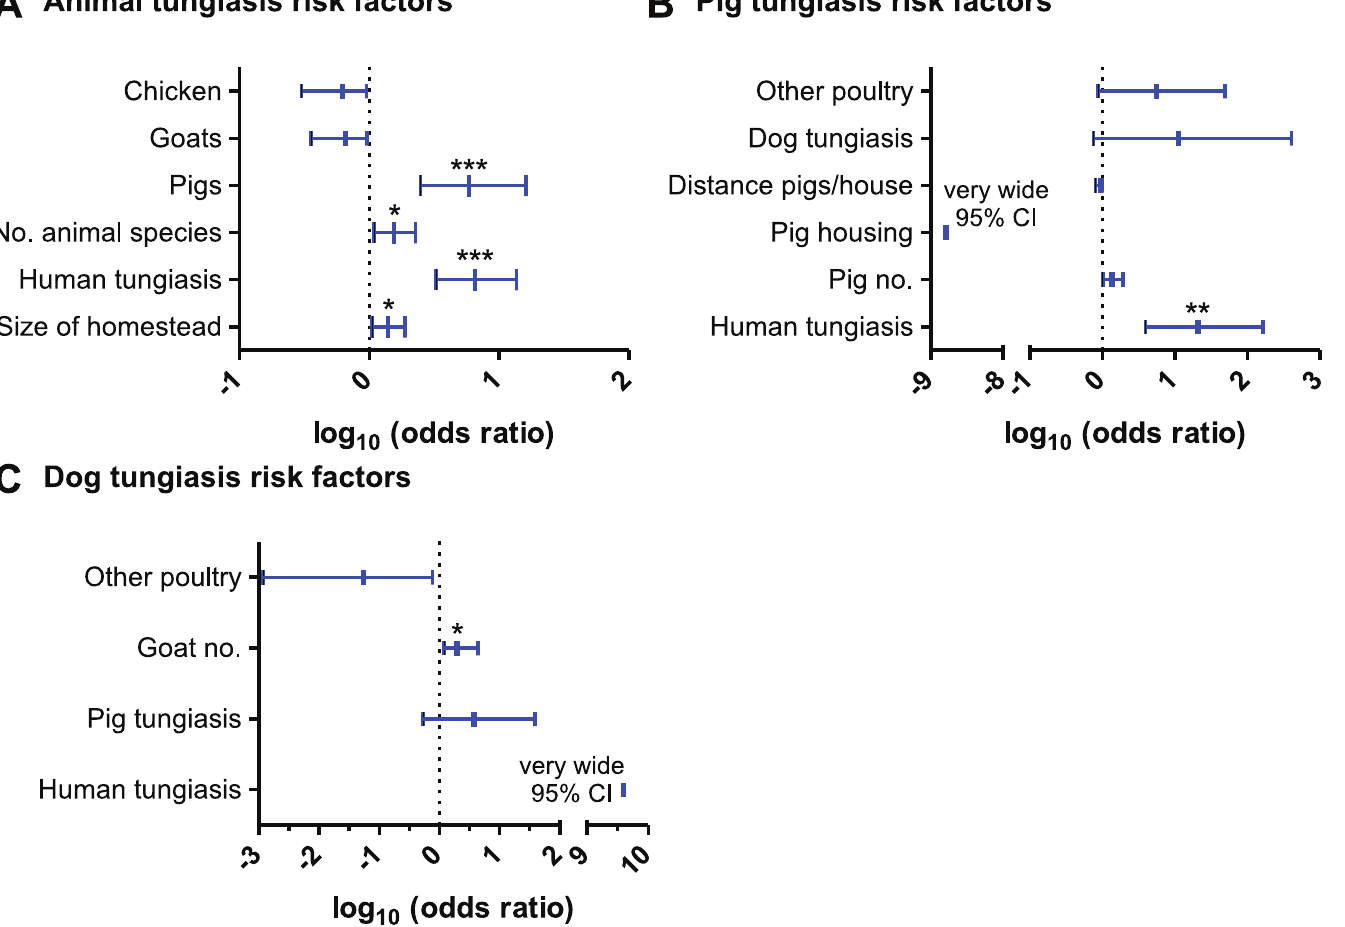
Fig 7. Multivariate risk factor analysis for animal tungiasis. Variables were analyzed by logistic regression and were eliminated stepwise to obtain an optimized model in terms of a minimal AIC value. Data are presented as odds ratios with 95% confidence intervals. (A), (B) and (C) show risks factor analysis for the presence of tungiasis in a household in any animal species, pigs and dogs, respectively. *** p < 0.001; ** , p < 0.01; * , p < 0.05. When confidence intervals were very wide, they were not